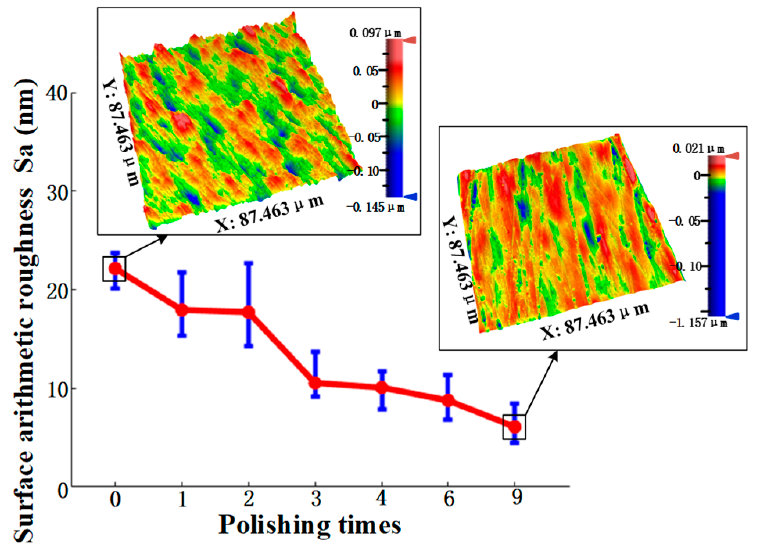
Figure 10. Pure rubber bonnet roughness under different polishing times.